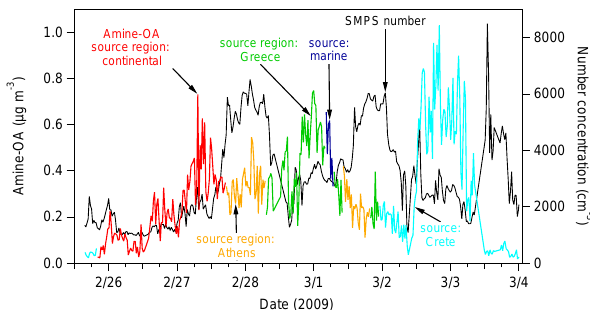
Fig. 9. Zoom of Amine-OA time series (left vertical axis) colored by the source region categorized as explained in the text. SMPS number concentrations (right vertical axis) do not correlate with Amine-OA